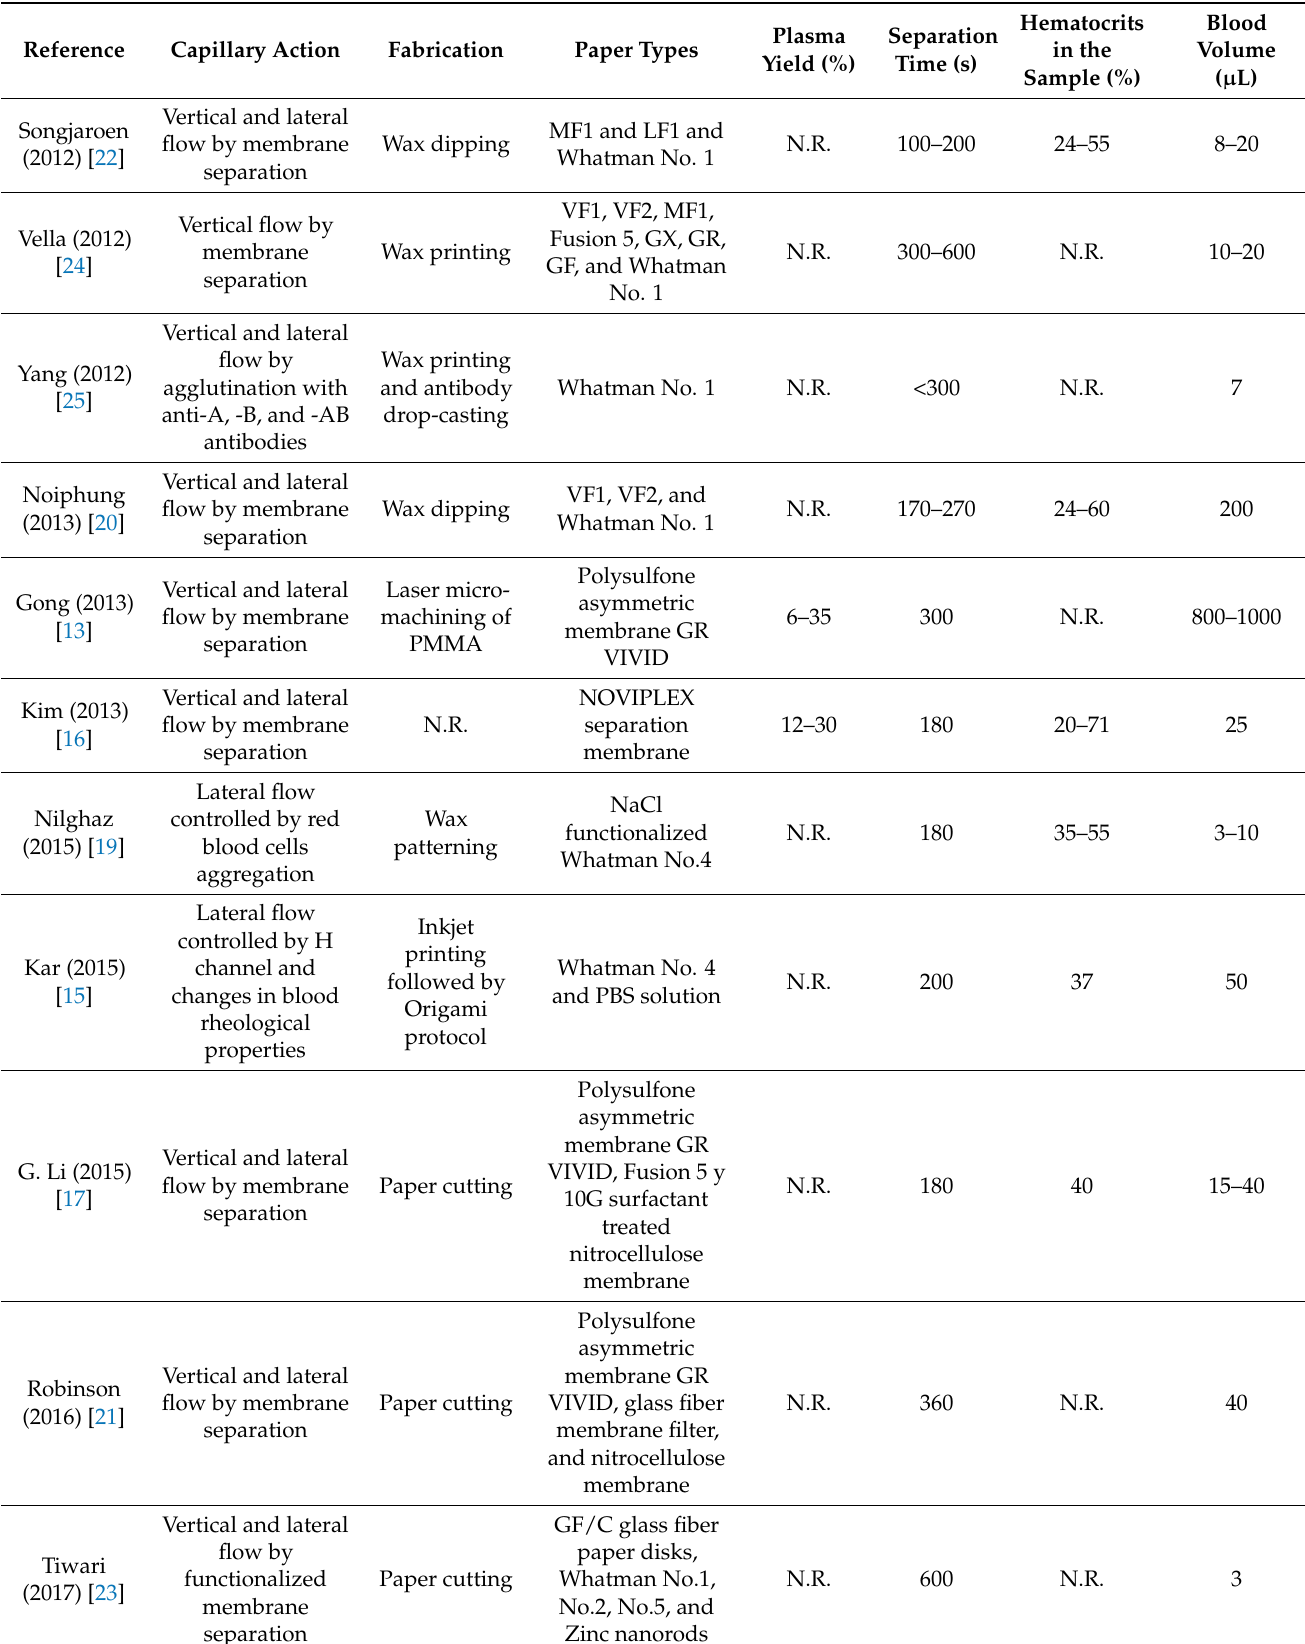
Table 1. Passive paper-based BPS prototypes found in the